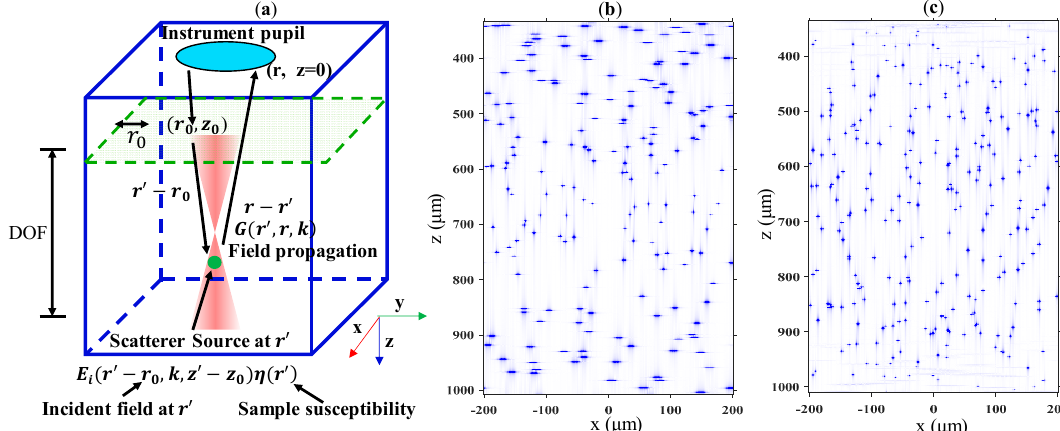
Figure 1. ( a ) The three-dimensional (3D) schematic diagram illustrating the interaction between the incident field and sample. The coordinates ( 0 r , z 0 ), ( ' r , z '), and ( r , z ) represent the incident position of the beam, the position of the scattered particle, and the position at which the scattered field is detected, respectively. The green dot in ( a ) represents a scattering particle. ( b , c ) Simulation results of Spectral domain optical coherence tomography (SD-OCT) and interferometric synthetic aperture microscopy (ISAM) applied to a scattering particle sample, respectively.